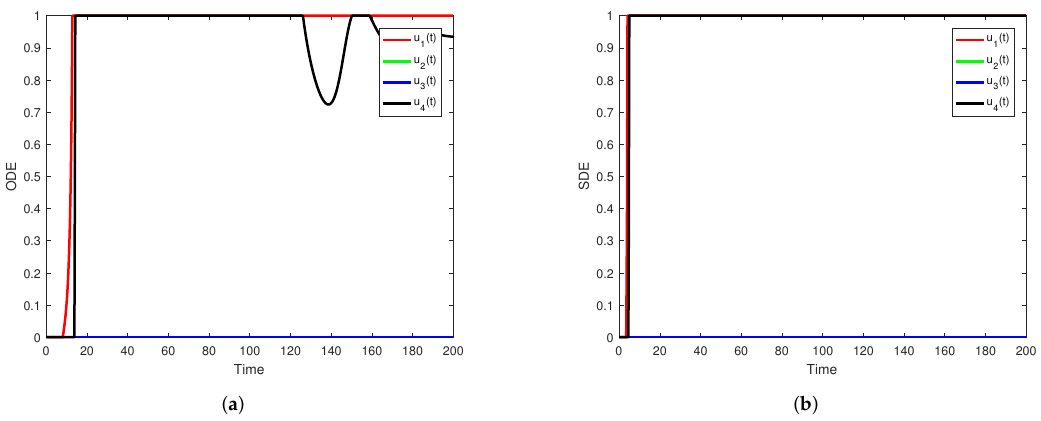
Figure 6. Simulations of ( u 1 ( t ) , u 2 ( t ) , u 3 ( t ) , u 4 ( t )) for the stochastic model (1) with its corresponding deterministic version. ( a ) Trajectories of the optimal control of the deterministic system with and with- out control. ( b ) Trajectories of the optimal control of the stochastic system with and without